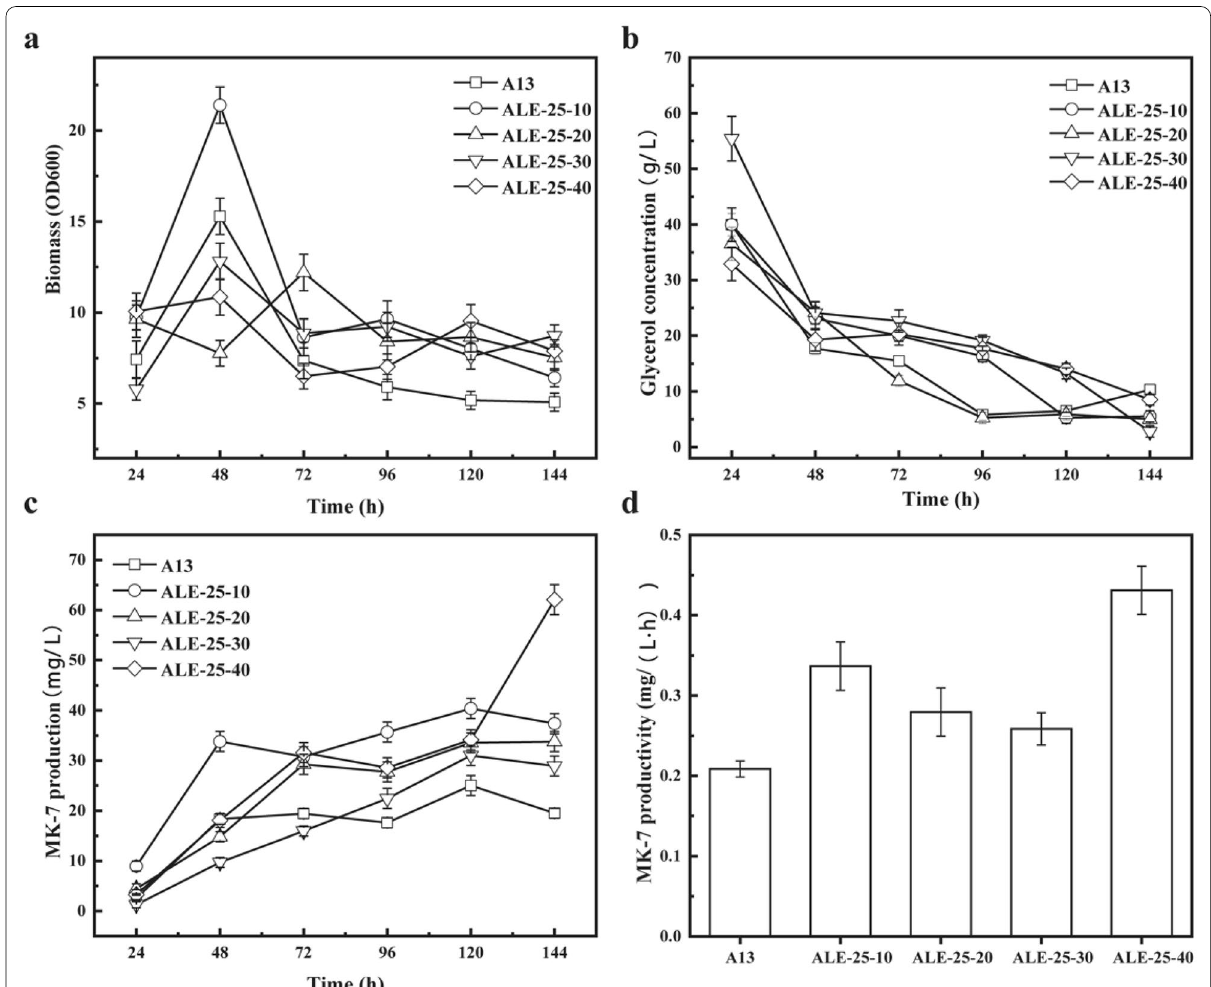
Fig. 2 Comparison of cell growth ( a ), glycerol concentration ( b ), MK-7 production ( c ), and MK-7 productivity ( d ) of different adaptive strains and original